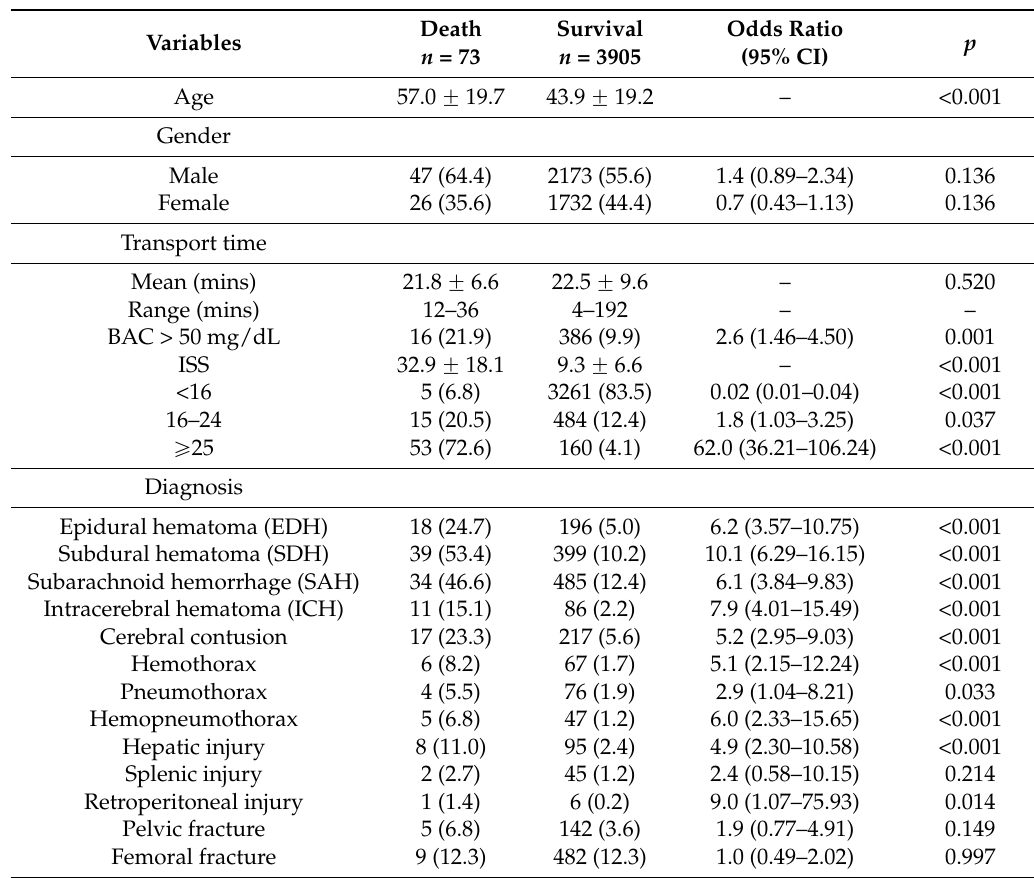
Table 6. Injury characteristics of death and survival patients that had been transported by Emergency Medical Services